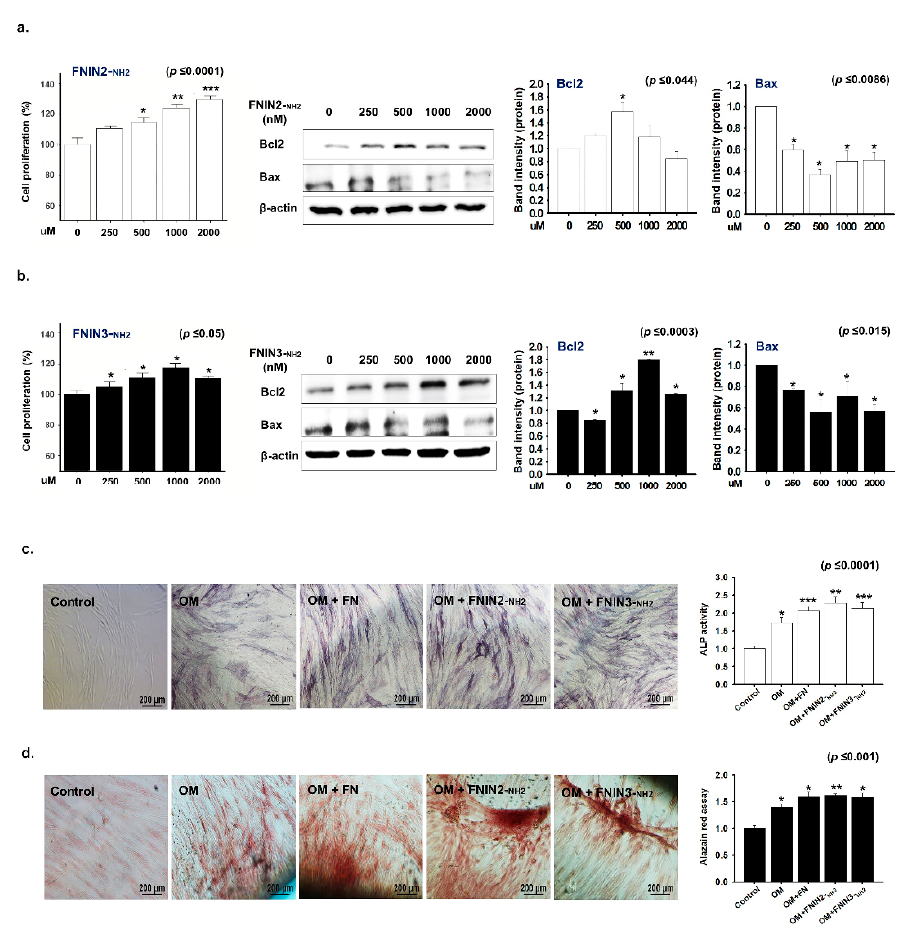
Figure 5. Effect of FNIN2- NH2 or FNIN3- NH2 on the proliferation and osteogenic differentiation of MSCs. Human adipose-derived mesenchymal stem cells (MSCs) were treated with different concentrations of FNIN2- NH2 or FNIN3- NH2 for 72 h and then cell proliferations and protein expressions were analyzed using a CCK-8 assay and by Western blot analysis, respectively. ( a , b ) MSCs proliferation and proteins (Bcl2 and bax) expression with FNIN2- NH2 or FNIN3- NH2 . ( c ) Quantification of alkaline phosphatase (ALP) activity in cells cultured in osteoblast differentiation media (12 days, magnification x100, scale bar = 200 µ m) ( d ) Quantification of alizarin red in cells cultured in osteoblast differentiation media (24 days, magnification x200, scale bar = 200 µ m). Non-treated cells were used as controls. Means ± SD ( n > 3). * p ≤ 0.05, ** p ≤ 0.001, *** p ≤ 0.0001.